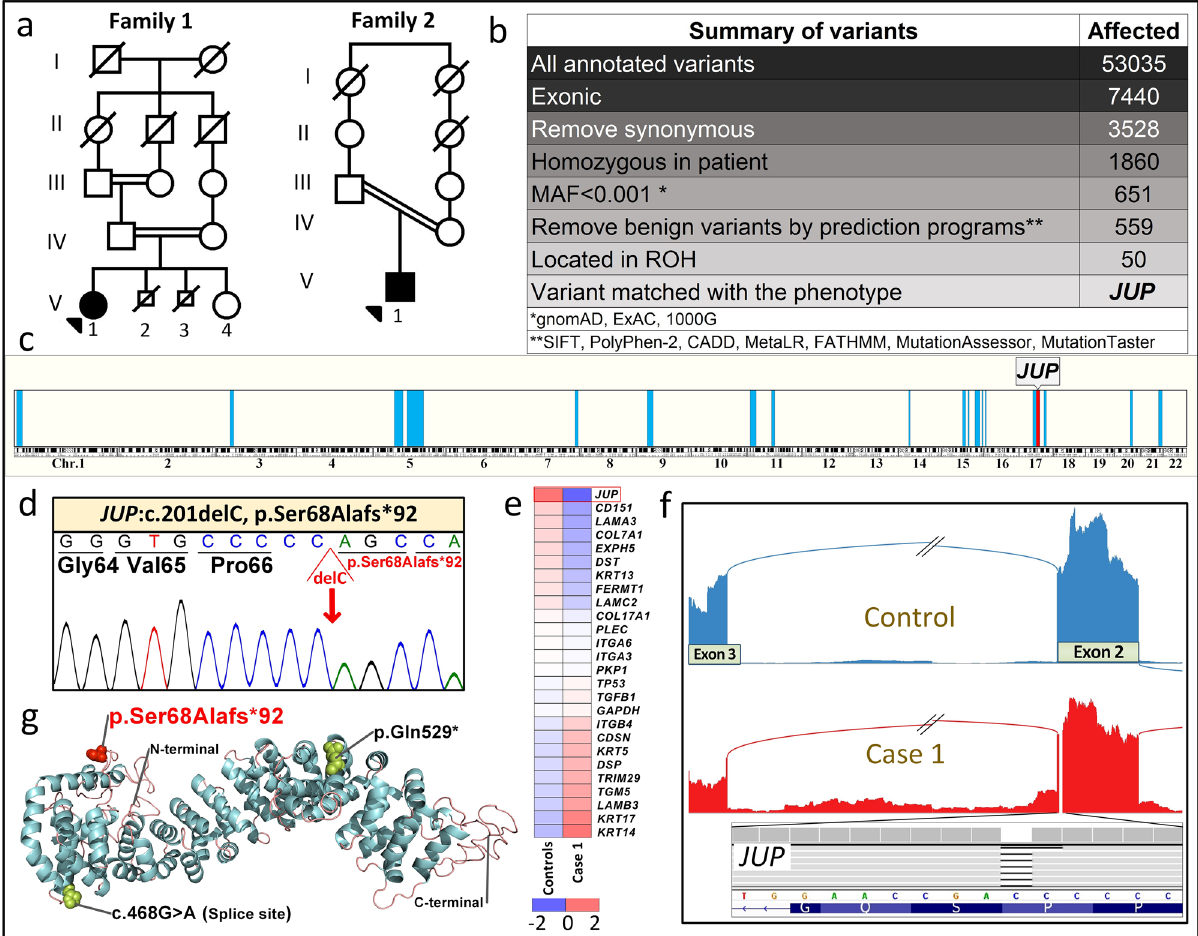
Figure 3. Identification of biallelic JUP mutations. ( a ) Pedigrees of two families with consanguinity. The proband in each family is indicated by an arrowhead. ( b ) Identification of the mutation in JUP by analysis of annotated variants from RNA-Seq data in Patient 2 using bioinformatics filtering steps indicated. ( c ) Homozygosity mapping based on RNA-Seq data localized the JUP gene within a homozygosity block of 10.7 Mb on chromosome 17. ( d ) Sanger sequencing confirmed the presence of the previously unreported homozygous mutation, JUP : NM_002230: exon 2, c.201_201delC, p.Ser68Alafs * 92, in both probands. ( e ) Heatmap visualization of transcriptome analysis revealed markedly reduced level of JUP expression in comparison to the pool of six healthy controls when compared to other genes associated with EB phenotypes and randomly selected housekeeping genes. ( f ) Sashimi plot of the transcriptome profile of the mutant JUP mRNA revealed normal splicing, indicating lack of exon skipping and/or significant intron retention. ( g ) Protein visualization of full-length JUP consisting of 745 amino acids. The mutation identified in this study (red) is predicted to result in a frameshift and early truncation of the protein. Two previously reported JUP mutations in patients with similar phenotype are shown (black). The figure was rendered in PyMol (v.2, Schrodinger, New York, NY). For details of WES, homozygosity mapping, RNA sequencing and protein modeling, see PyMol, http://Rymol .org 18,24,28,43 PSAX RVOT/BSA were 21 mm/m 2 and 24 mm/m 2 , respectively. Cardiac magnetic resonance imaging (CMRI), with and without Gadolinium, revealed normal myocardial thickness and wall motion, normal chamber size, volume and function, and no delayed myocardial enhancement (Fig. 2b–e). She met at least two major criteria (anterior T wave inversion and the JUP mutation) and one minor criterion (TAD > 55 ms) of the 2019 modified Task Force criteria giving her a definite diagnosis of ARVC 27 . Mutation detection. Two different approaches were used for mutation detection. First, DNA-based next- generation sequencing (NGS) utilized a panel consisting of 21 genes associated with different skin fragility syn- dromes, including EB 18 . For targeted NGS, DNA was isolated from peripheral blood samples taken from the patients, their parents, and other clinically affected and unaffected family members. For details of the library construction, data capturing and bioinformatics, see the references 23,25 . The second mutation detection approach utilized RNA-based NGS via RNA-Seq analysis of a whole skin biopsy from Patient 2 as well as six unrelated healthy controls. The resulting data derived from transcriptome-wide variant calling (Fig. 3b), whole-genome